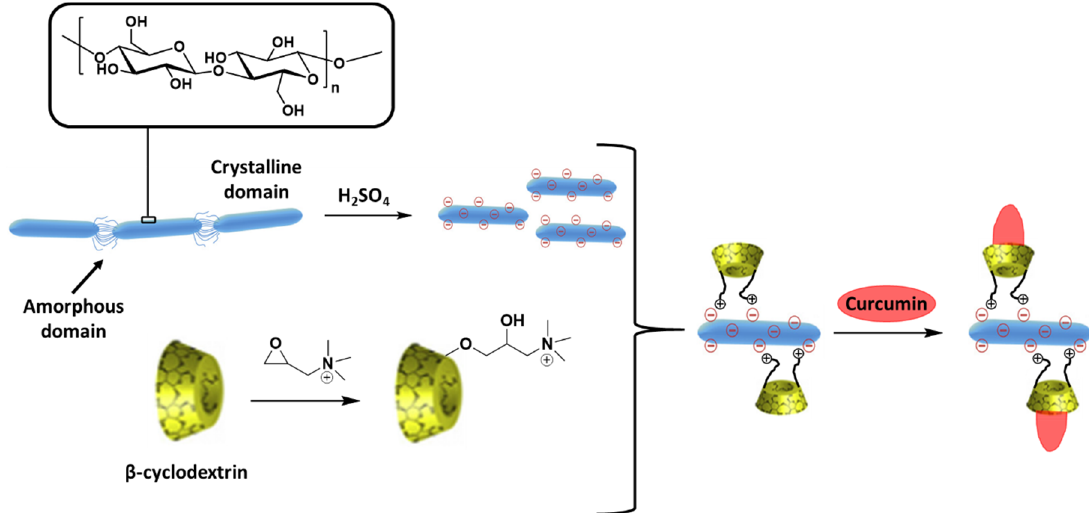
Figure 16. Synthesis pathway for the preparation of cellulose nanocrystals complexes with encapsulated CUR. Adapted with permission from [104] ; copyright (2016) Elsevier.